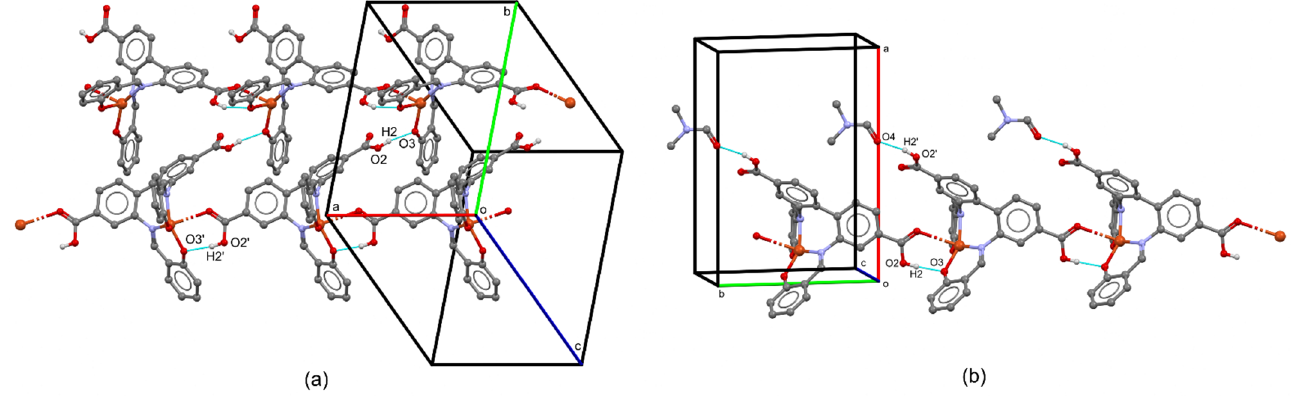
Figure 4. Hydrogen bonding in the complexes. ( a ) {[ Cu(H 2 L)]· x MeOH} n ( 1 ); ( b ) {[Cu(H 2 L)]·DMF} n ( 2 ).